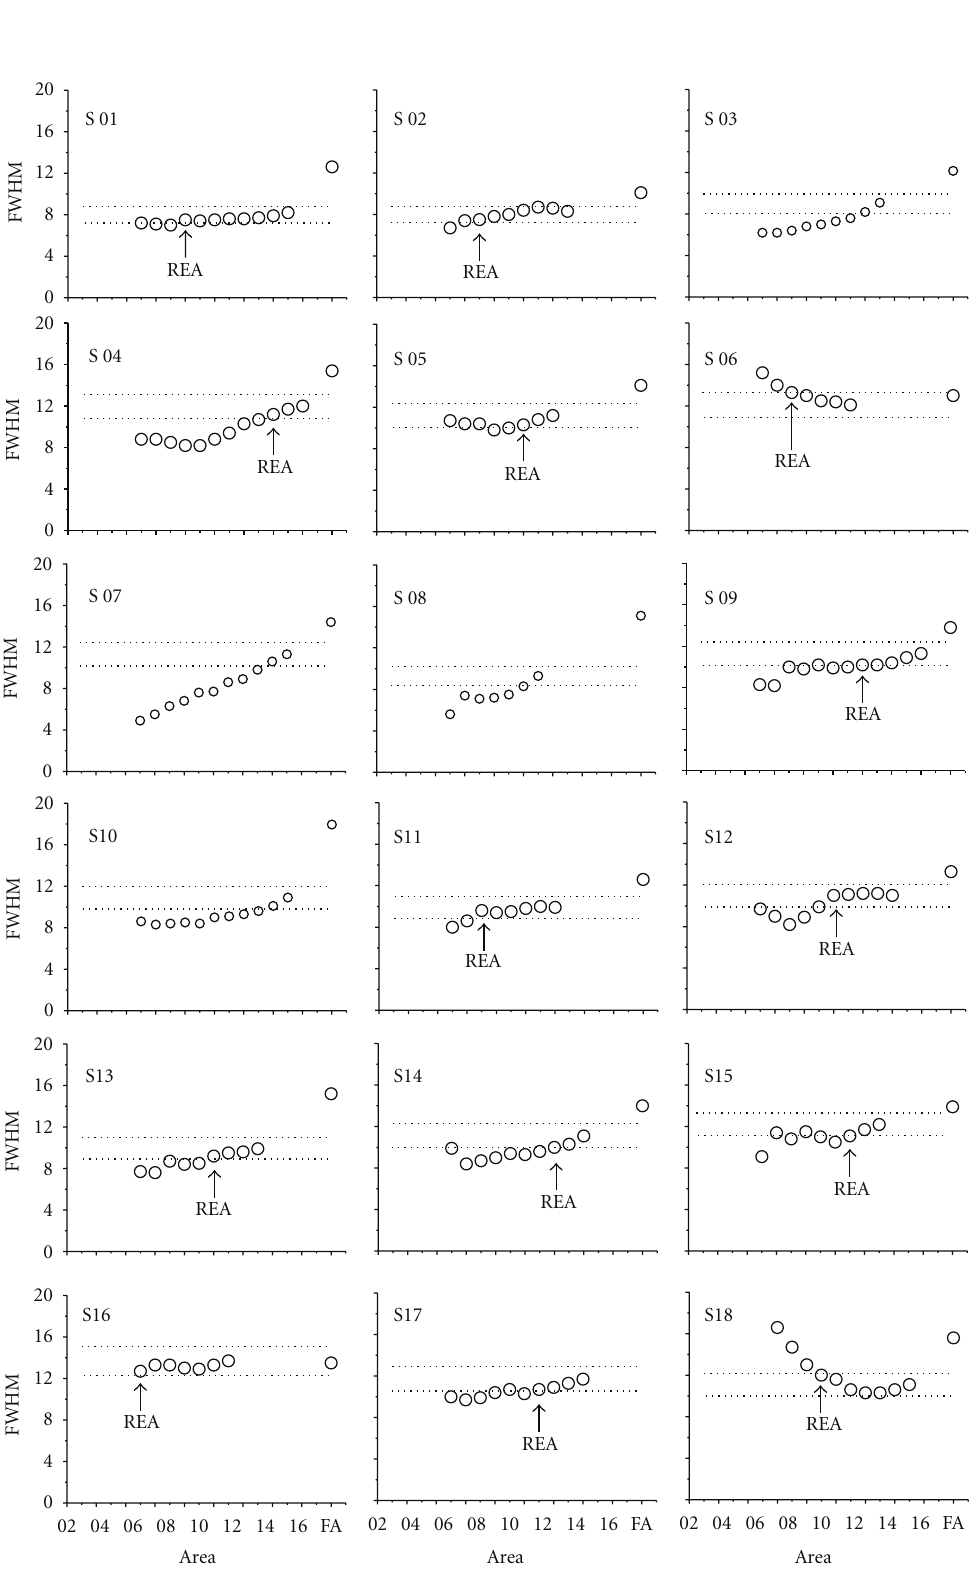
Figure 9: Graphs to depict values of FWHM from the 5th area selected in 18 samples (S 01, S 02, ... , and S 18) and its respective representative elementary areas (REA) for a deviation of 10% when the REA was